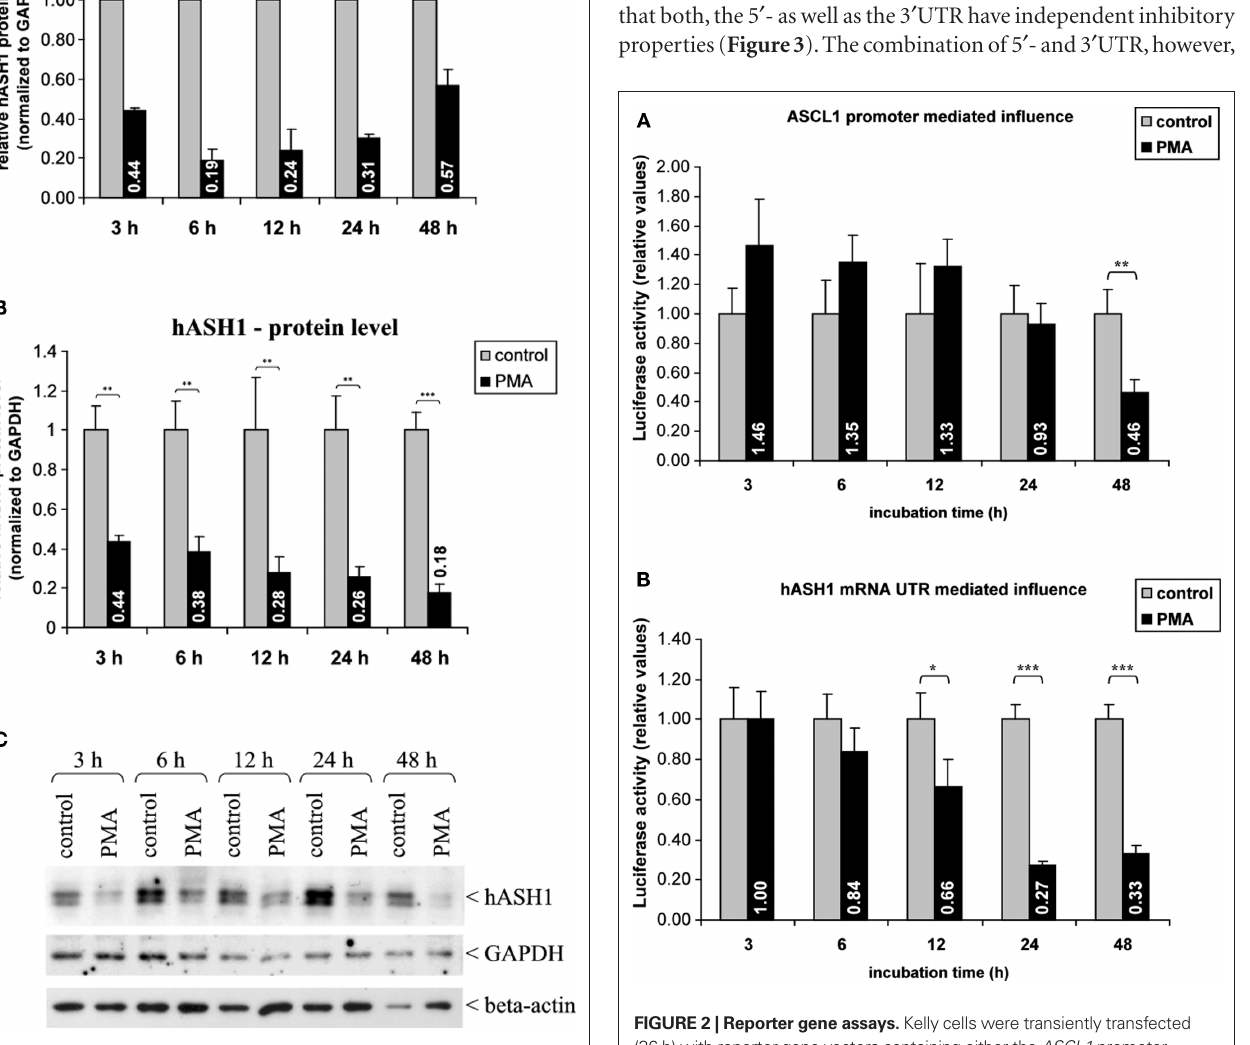
Figure 1 | Human achaete-scute homolog-1 mrNA and protein levels following PMA (40 nM) treatment. (A) Determination of hASH1 mRNA levels by qRT-PCR ( n = 9). (B) Statistical analysis of hASH1 protein levels obtained by Western Blotting ( n = 6). (C) Representative Western blot analysis. Pools of six independent samples per condition are shown. Control cells were treated with PMA solvent (ethanol). Detection of GAPDH and beta-actin served as loading controls. Shown are mean values, and error bars represent the standard deviation (SD). * p < 0.05, ** p < 0.01, *** p < 0.001.